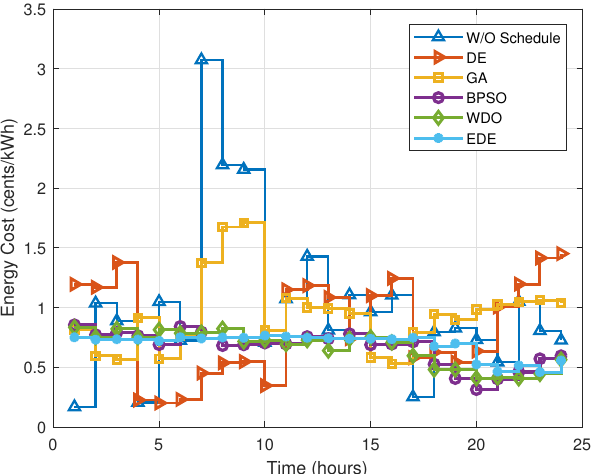
Figure 19. Energy cost per hour evaluation after scheduling hybrid appliances.